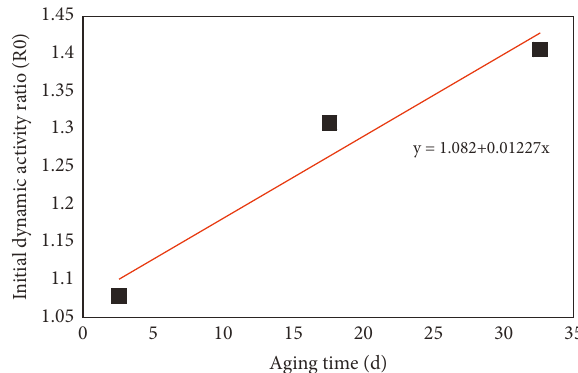
Figure 5: Dynamic initial activity ratio-aging time curve.